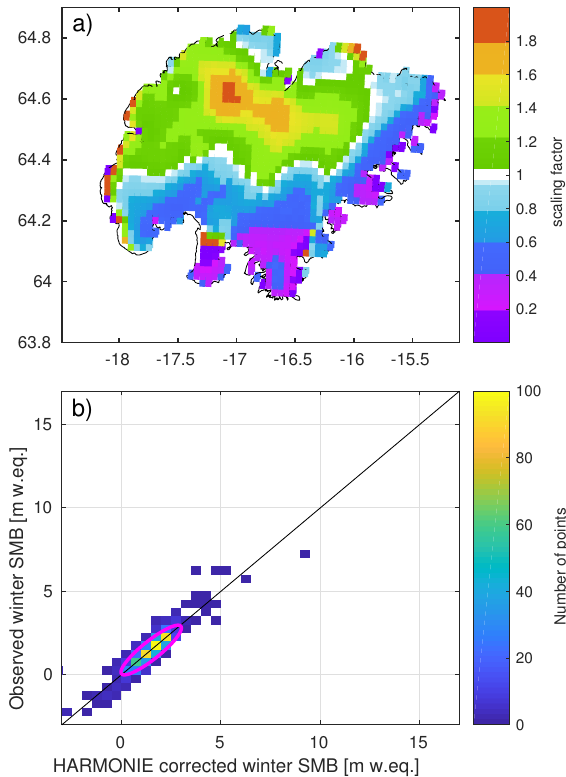
Figure 4. ( a ) The scaling matrix used for correction of each winter snowfall; ( b ) comparison between winter mass balance observations and the modeled corrected winter mass balance for 1992–2015. The RMSE is 0.4 m w.eq. and the correlation r = 0.89. Color bar shows how many points are in the same spot and purple ellipsis outlines 68% of the